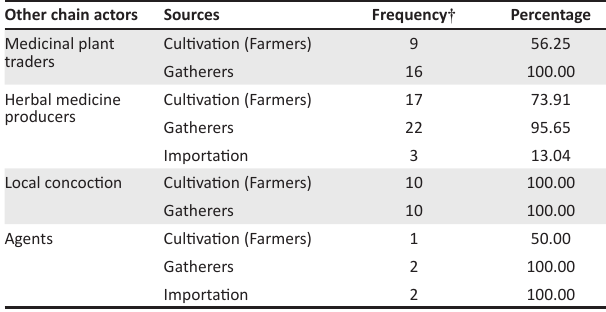
TABLE 3: Sources of medicinal plants.